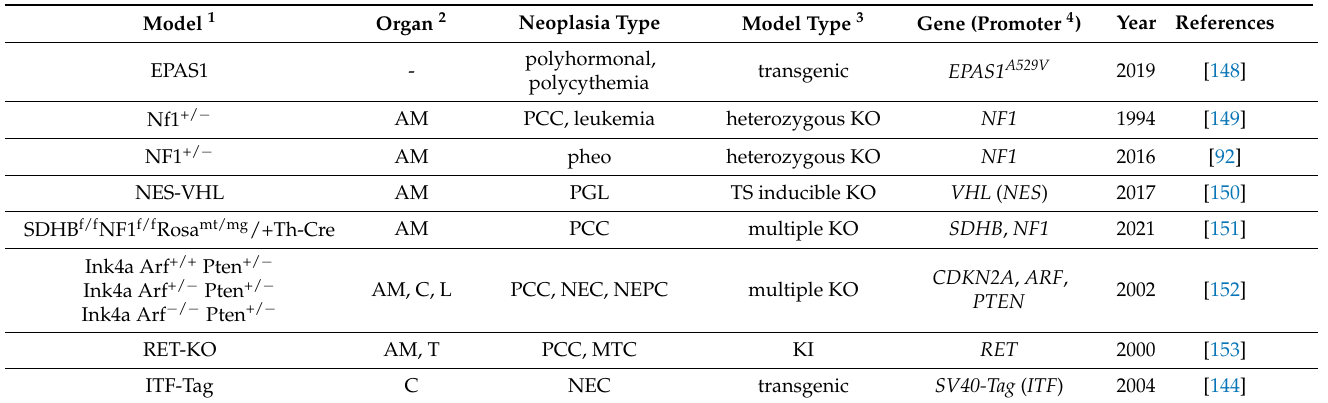
Table 4. Genetically-engineered mouse models of neuroendocrine